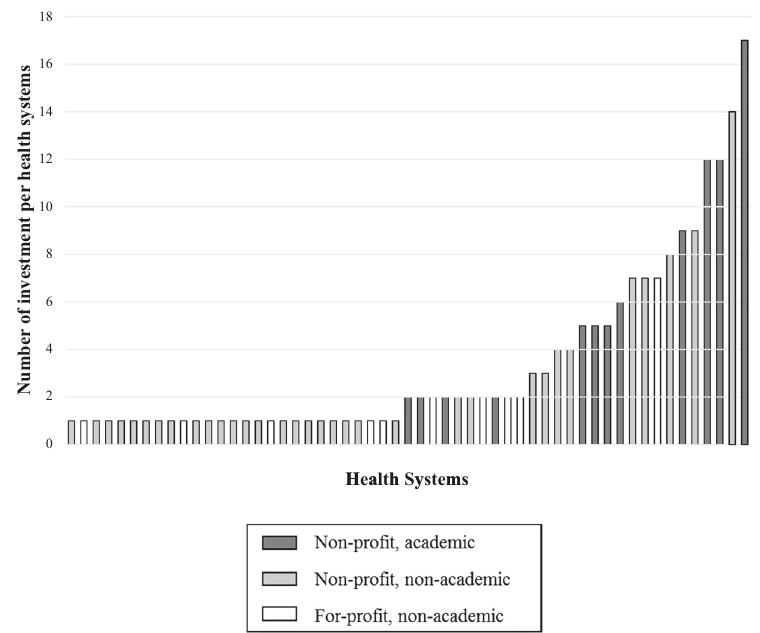
Fig. 2 Volume of digital health investment deals by individual health systems. Total volume of investments in digital health companies by individual health